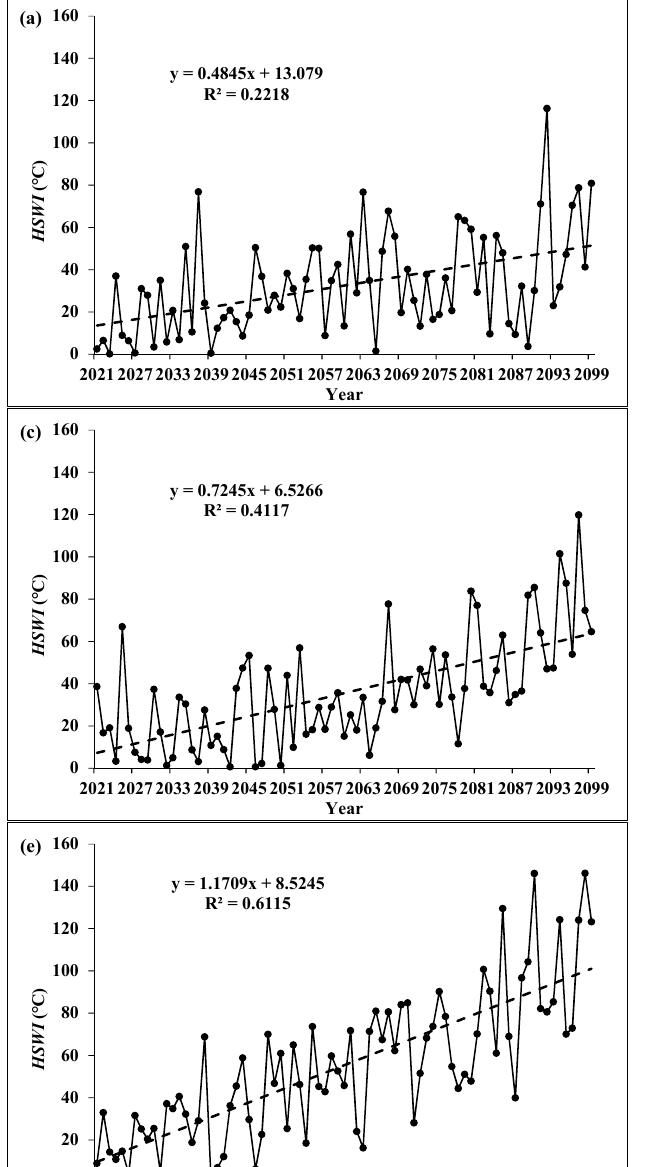
From 2021 to 2099, the projected HSWI showed marked interannual fluctuations and increased significantly at rates of 5.2 ◦ C per decade ( p < 0.001), 7.2 ◦ C per decade ( p < 0.001) and 11.7 ◦ C per decade ( p < 0.001) under RCP 4.5, RCP 6.0 and RCP8.5, respectively (Figure 6a,c,e), all greater than 1.7 ◦ C per decade based on observations. The rise was faster with higher radiative forcing levels, and the rate under RCP8.5 was twice that under RCP4.5. The projected payout presented similar variation characteristics to those of the HSWI from 2021 to 2099. It also fluctuated considerably and increased at rates of 13.1 CNY mu − 1 per decade ( p < 0.001), 18.8 CNY mu − 1 per decade ( p < 0.001) and 20.9 CNY mu − 1 per decade ( p < 0.001) under the three RCPs (Figure 6b,d,f), all greater than 4.0 CNY mu − 1 per decade based on observations.